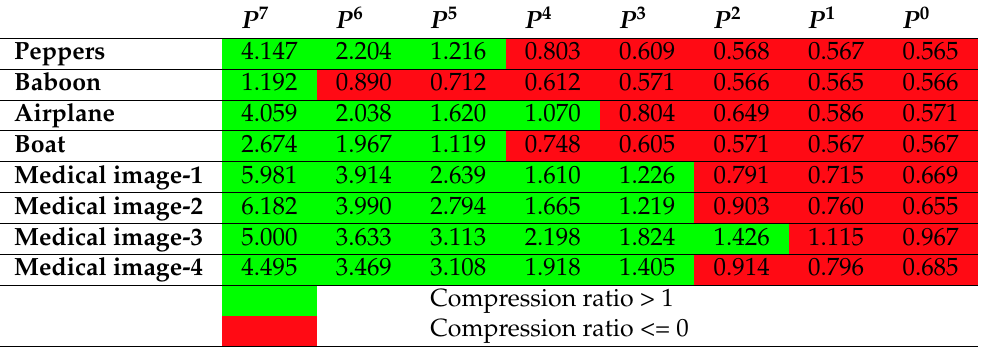
Table 1. Compression ratio obtained from sample images.